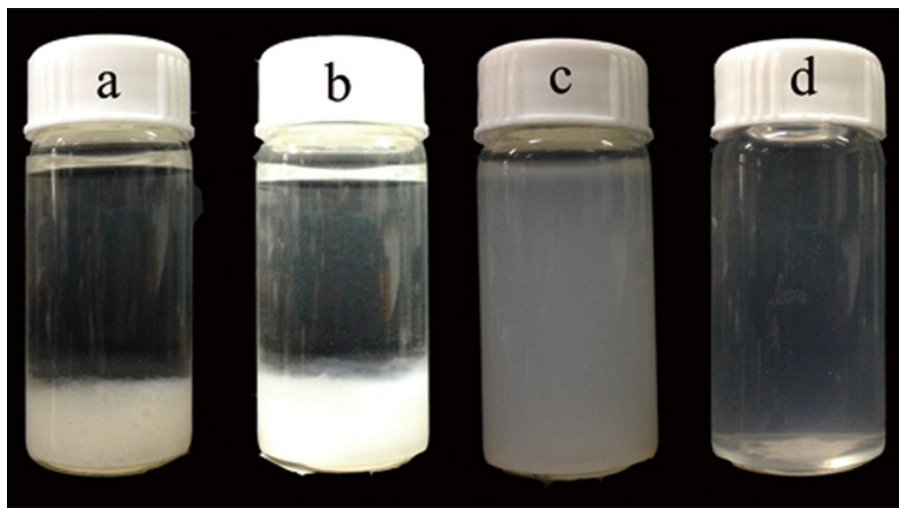
Fig 1. Photographs of samples in different stages: (a) after acidified sodium chlorite treatment, (b) after sodium hydroxide and hydrochloric acid treatment, (c) after grinding, and (d) after